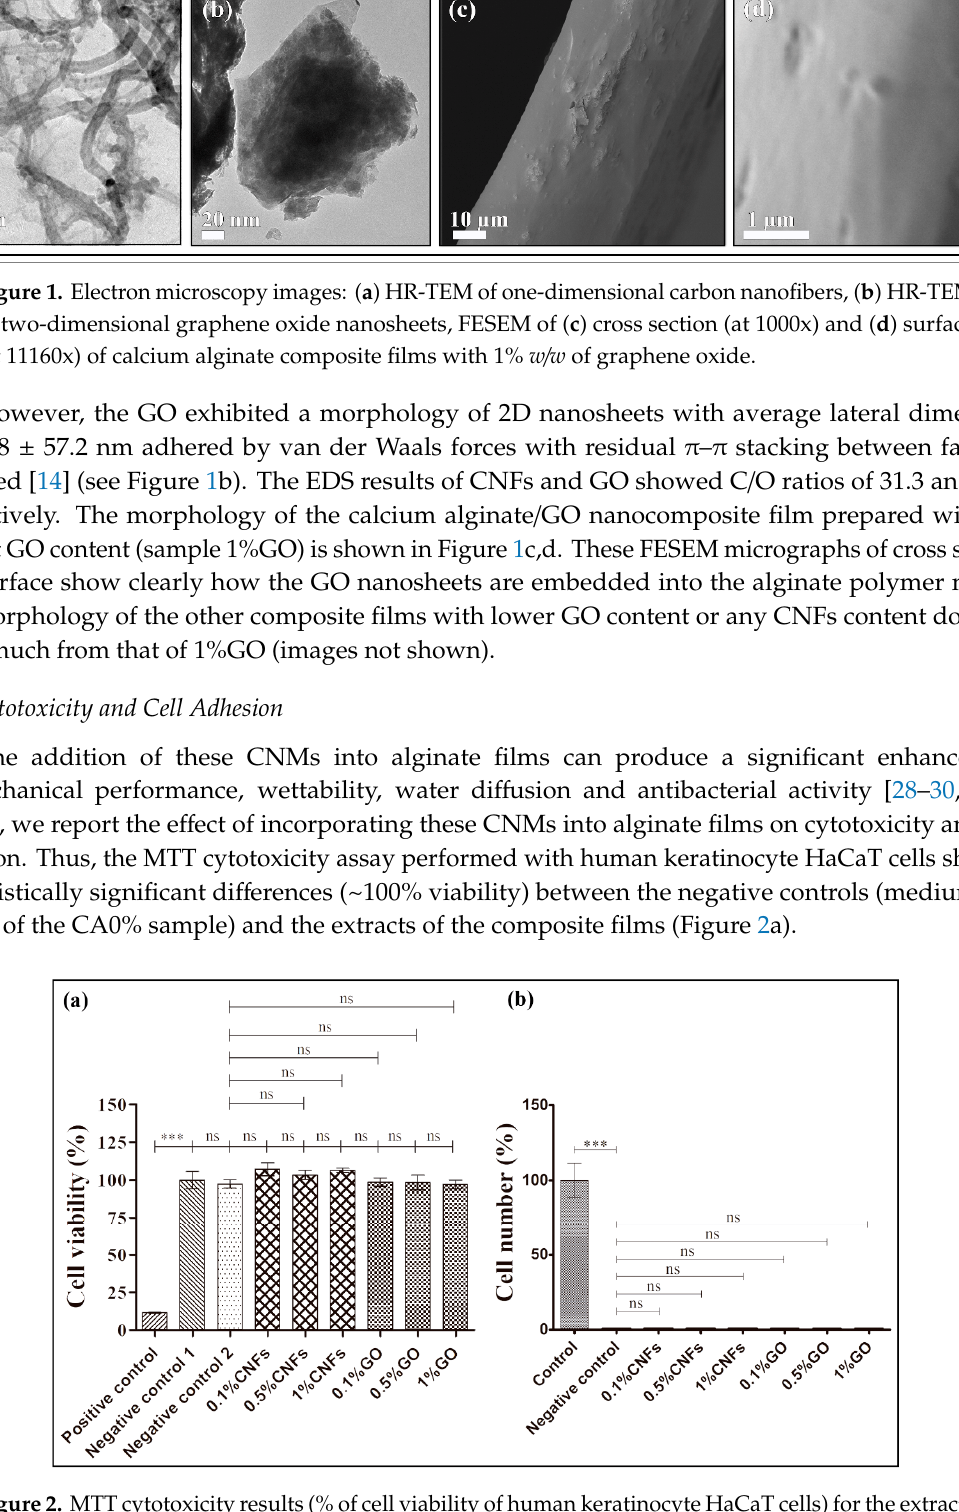
Figure 2. MTT cytotoxicity results (% of cell viability of human keratinocyte HaCaT cells) for the extracts of the calcium alginate films with 0.1%, 0.5% and 1% w/w of CNFs or GO nanosheets, negative control 1 (medium), negative control 2 (calcium alginate without carbon nanomaterials) and positive control (zinc) ( a ), and cell adhesion quantification results by DAPI staining ( b ) on glass coverslips (control) and calcium alginate with 0 (negative control), 0.1%, 0.5% and 1% w / w of CNFs or GO nanosheets. Data was expressed as mean ± SD and compared by ANOVA-Tukey’s post-hoc: *** p > 0.01; ns: not